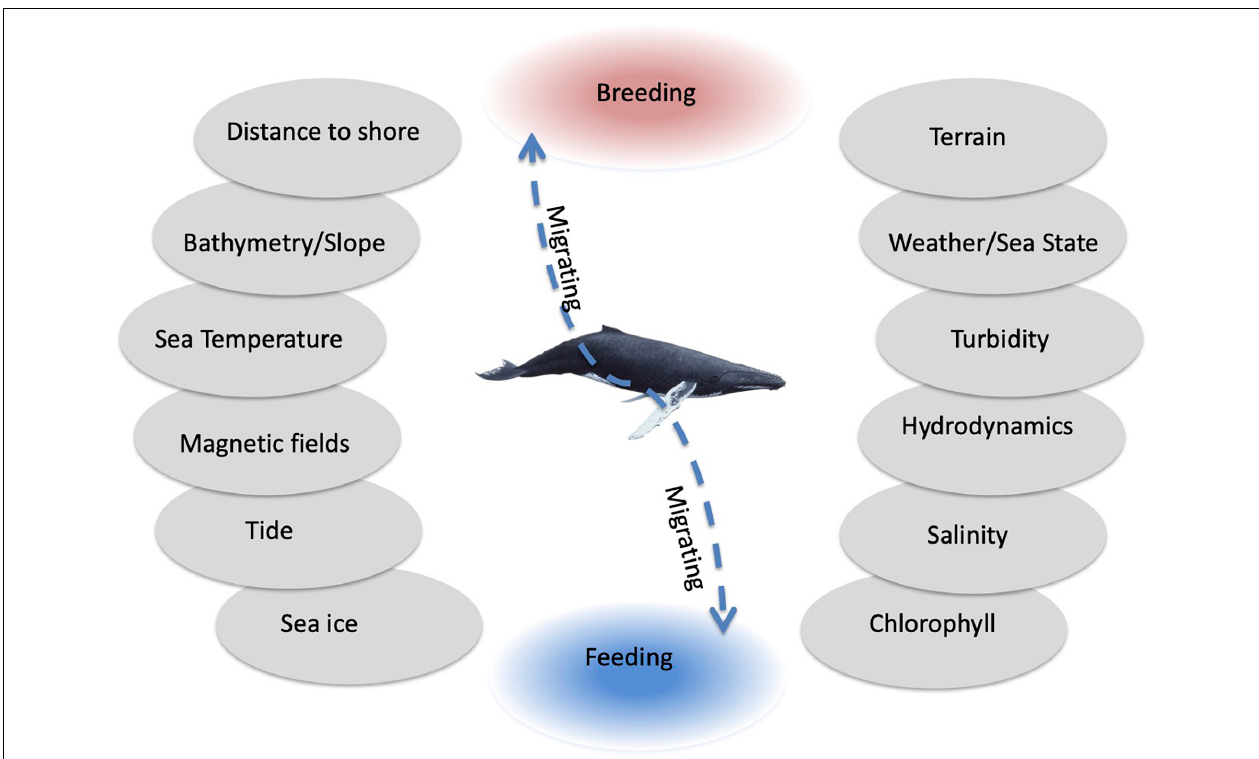
FIGURE 6 | The main environmental drivers in order of relevance to humpback whale breeding (red), migration (dashed line), and feeding (blue) from bottom to top (e.g., sea ice concentration and chlorophyll being more important for feeding and distance to shore and terrain being more important for breeding).